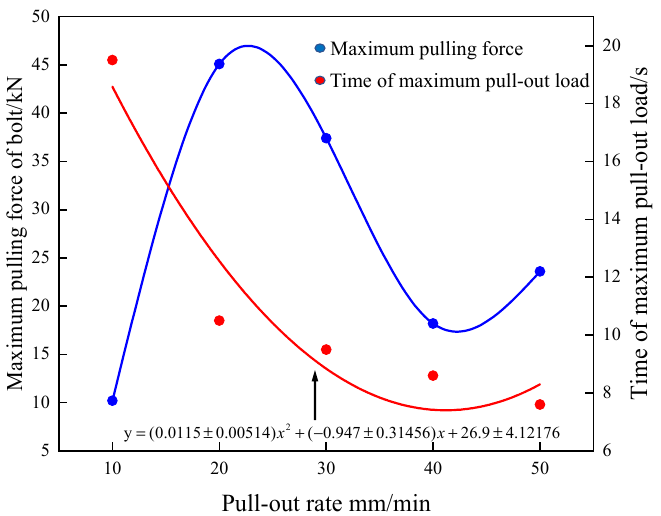
( b ) Figure 8. Relationship between maximum drawing force and maximum pull-out load time under different pull-out rates: ( a ) axial force; ( b ) interfacial shear stress.